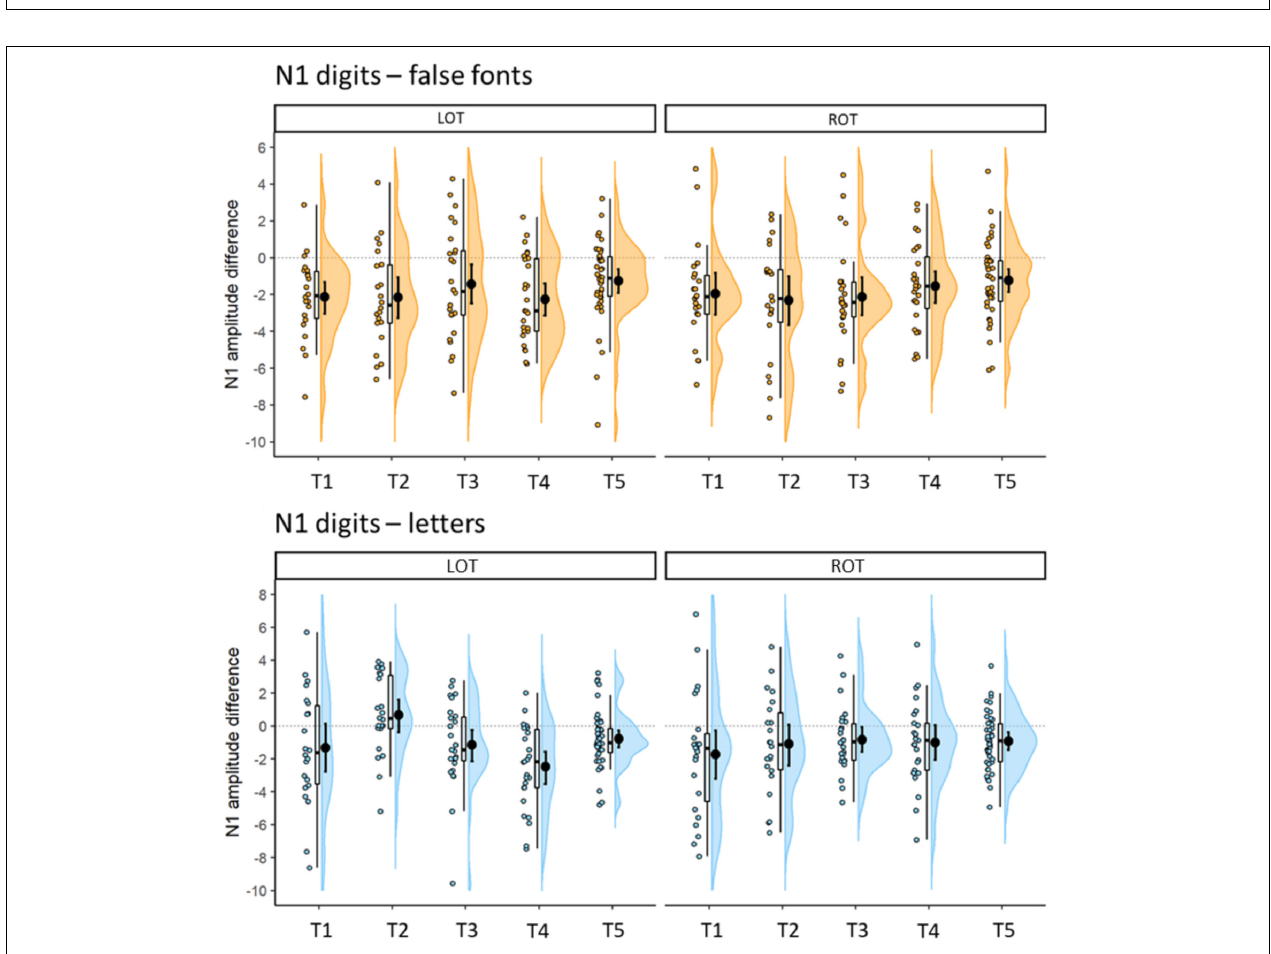
FIGURE 5 | Differences in N1 mean amplitudes ( µ V) between digits and false fonts (coarse digit sensitivity: top plots) and digits and letters (fine digits sensitivity: bottom plots) per time point. Error bars within the density plot indicate mean and 95% CIs. More negative values indicate stronger negative amplitudes for digits than false fonts (top) or letters (bottom), respectively. Left (LOT) hemispheric cluster is depicted on the left panel, right (ROT) hemispheric cluster on the right.